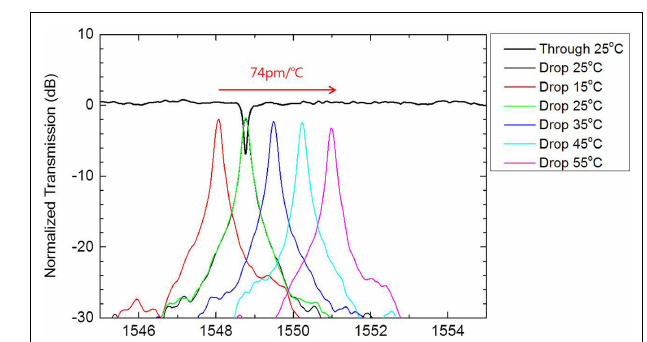
FIGURE 6 | Normalized transmission spectra of the ring resonator with silica cladding mentioned in Figure 5, as the temperature varied from 15 to 55°C